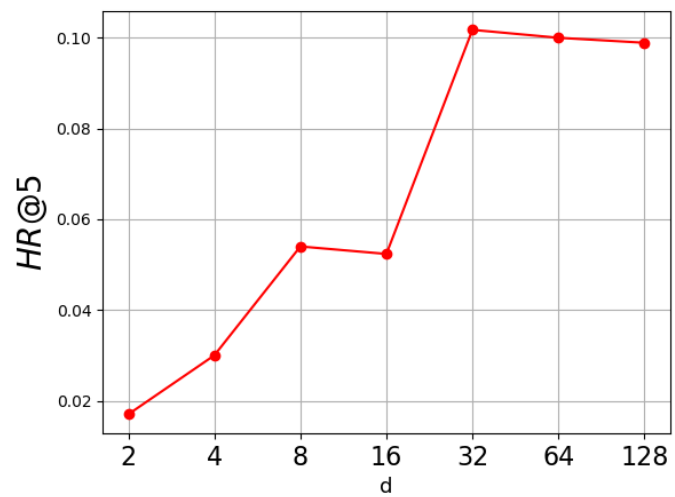
Figure 5. HR@5 with respect to embedding dimension d .